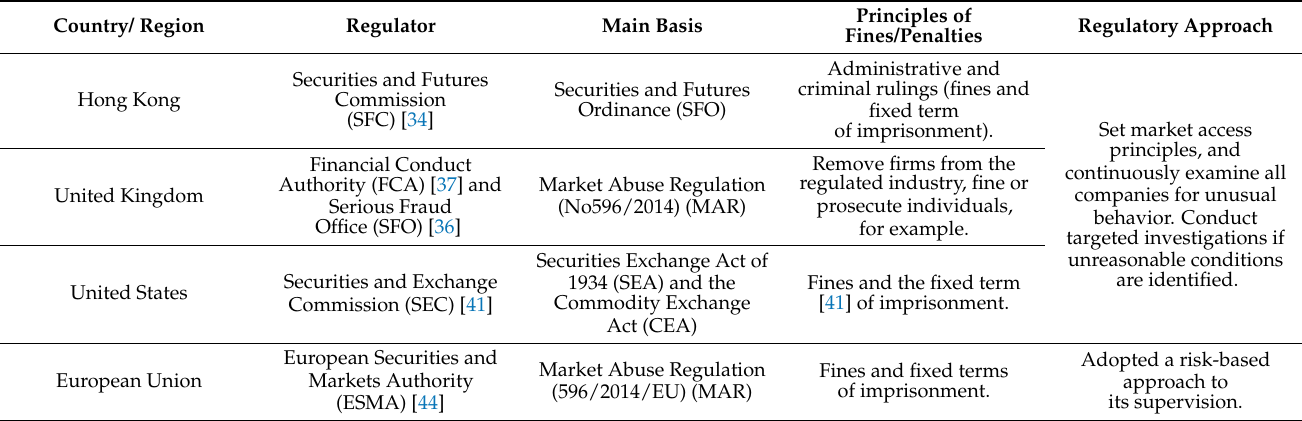
Table 1. Regulatory measures of manipulative behavior in the stock market for Hong Kong, the United Kingdom, the United States and the European